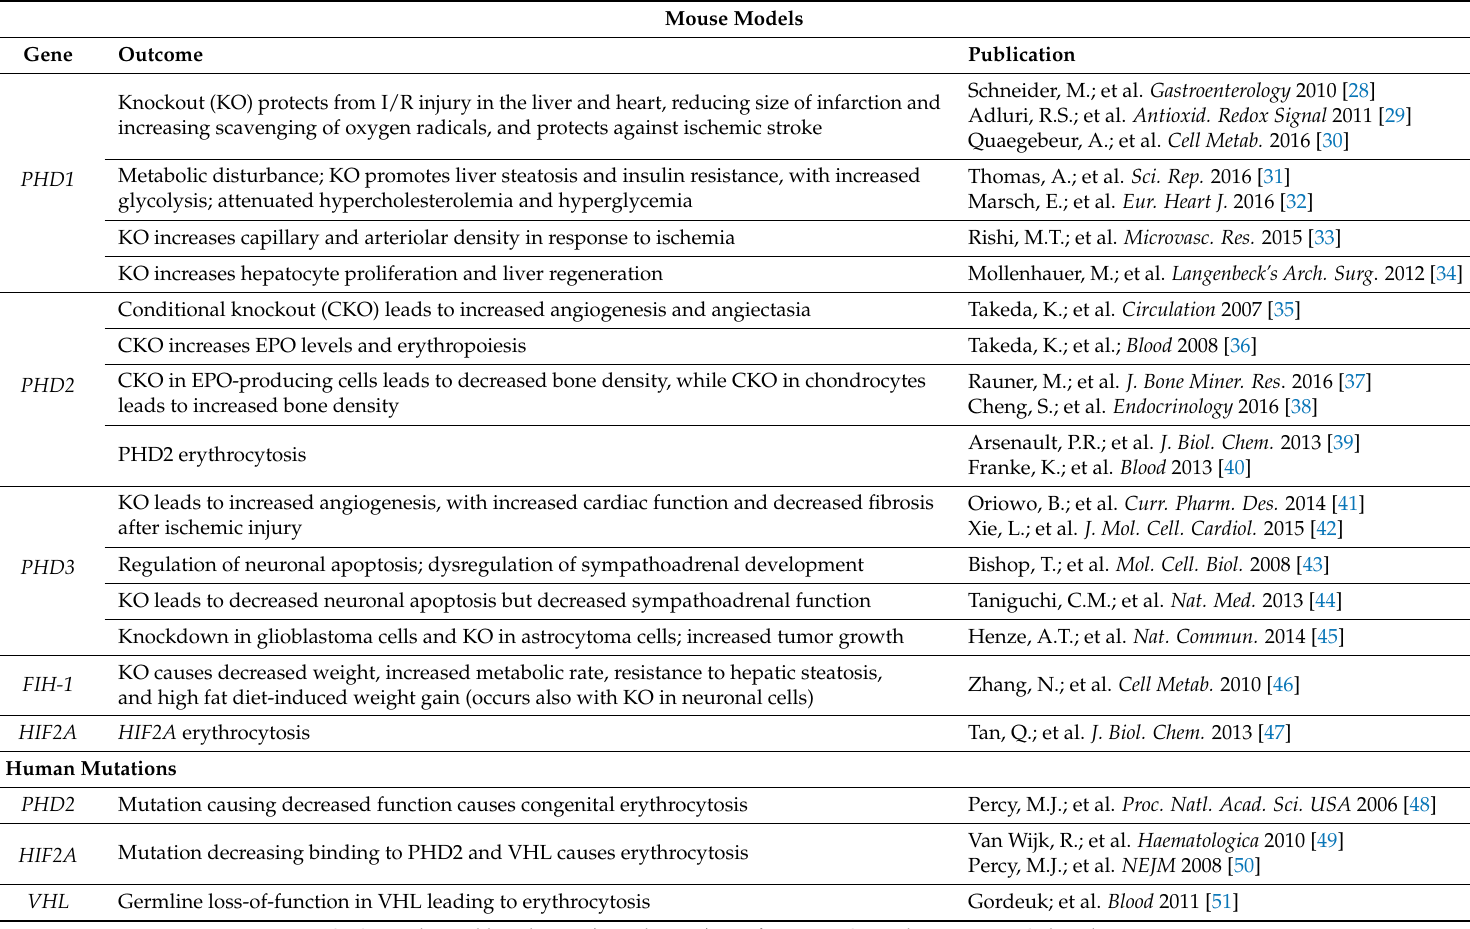
Table 1. Impact of prolyl-hydroxylase domain (PHD), hypoxia-inducible factor (HIF), factor inhibiting HIF (FIH), and von Hippel-Lindau gene (VHL) mutations on cellular and tissue